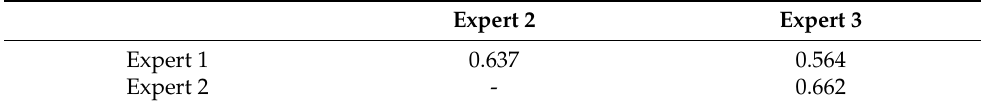
Table 4. Weighted Kappa